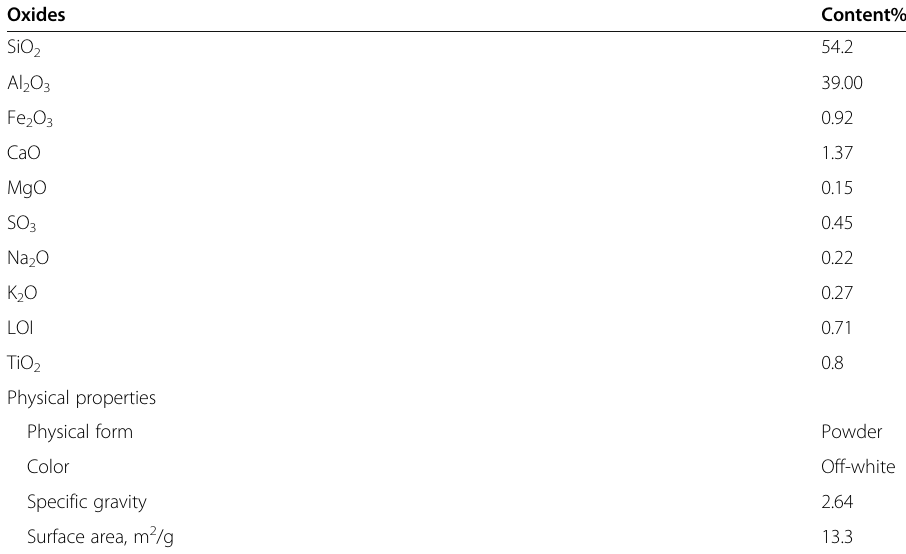
Table 1 Chemical analysis and physical properties of metakaolin